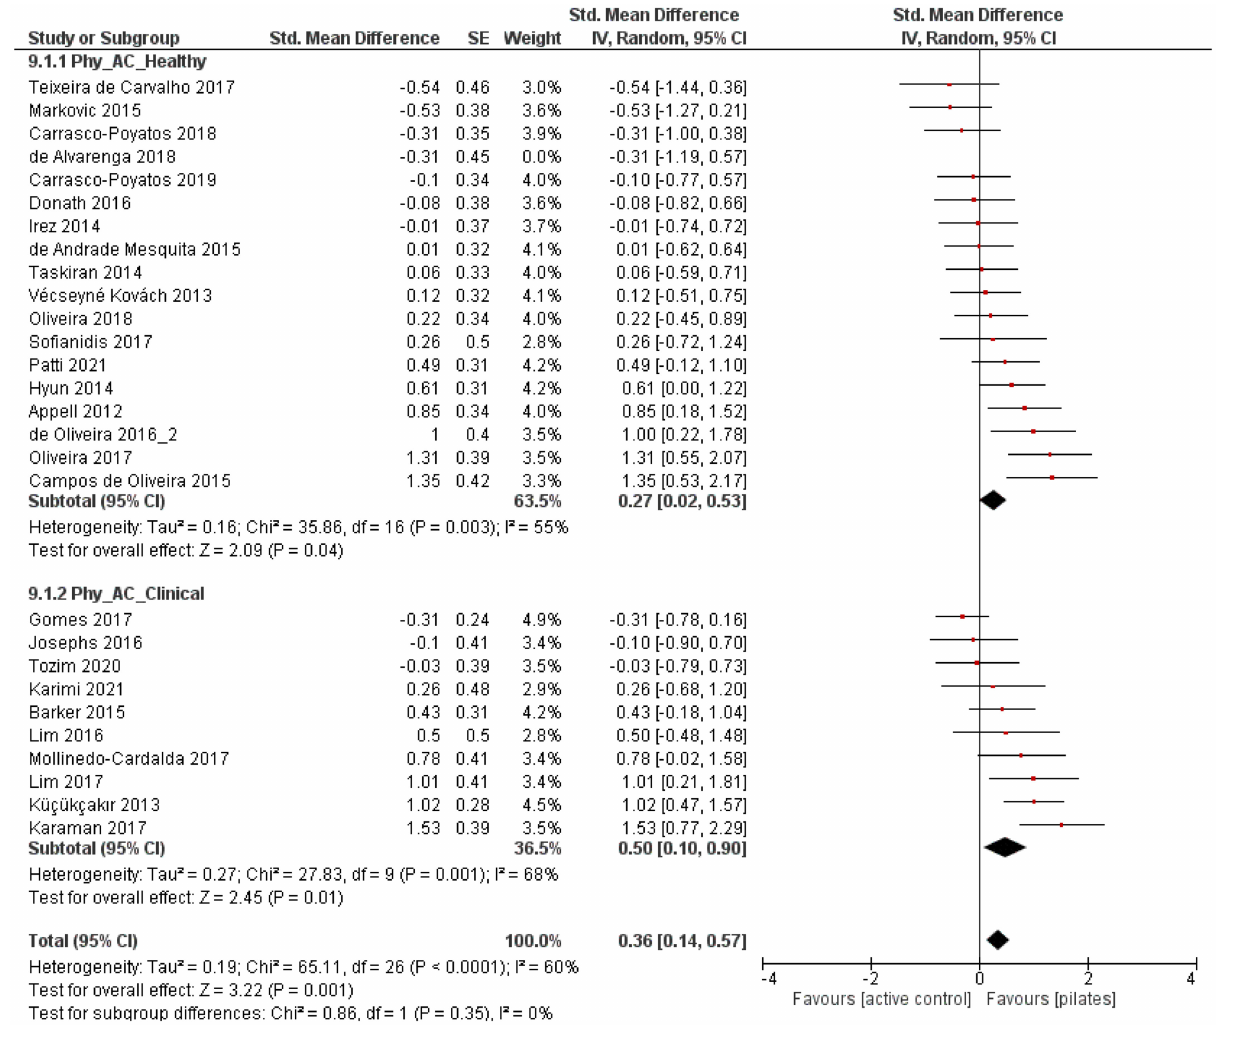
FIGURE 6 | Forest plot of standardized mean effects of Pilates intervention on physiological health parameters compared to active control (AC) groups. Data are presented for healthy older adults and older adults with clinical conditions. SE, standard error; IV, inverse variance model; CI, confidence interval; Std.,